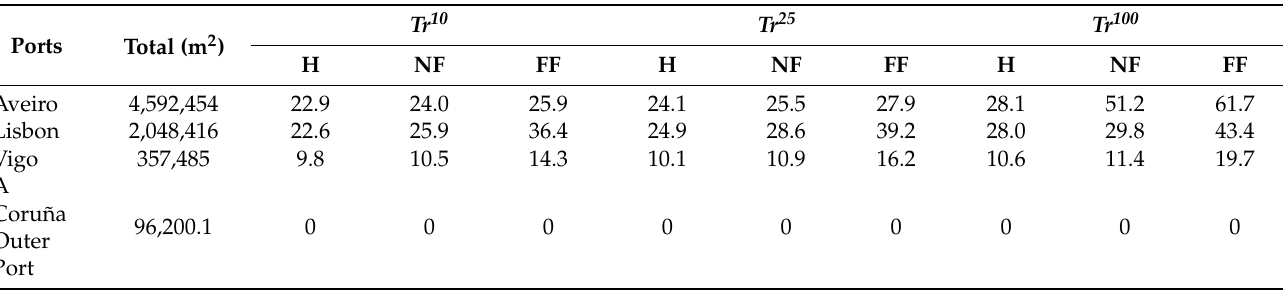
Table 7. Flooded areas of the terminals at the ports are shown in percentage (%) relative to the total area of each terminal for the historical (H), near future (NF) and far future (FF) periods, and for the 10-, 25-, and 100-year return